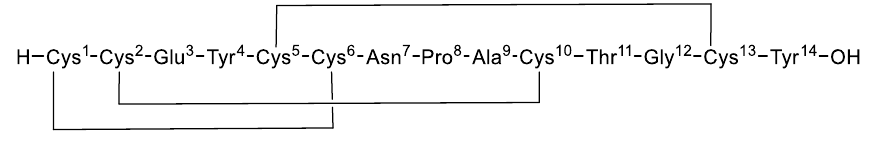
Figure 1. Structure of linaclotide.